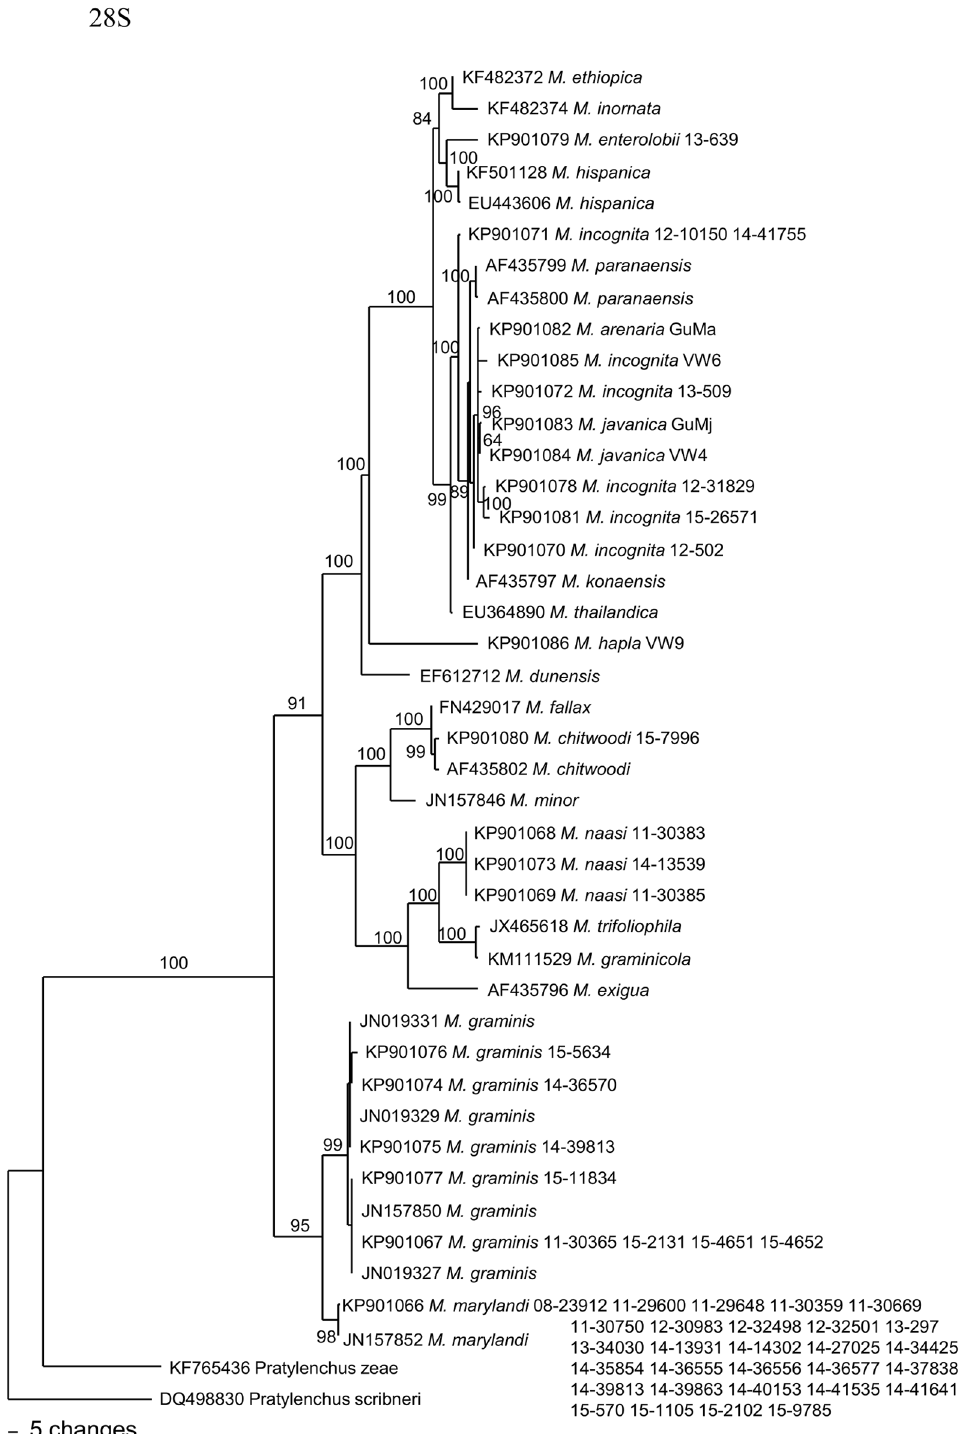
Fig 3. The 10001st Bayesian tree inferred from 28S D2/D3 under TVM+I+G model (-lnL = 4970.2949; AIC = 9958.5898; freqA = 0.2484; freqC = 0.1933; freqG = 0.2727; freqT = 0.2855; R(a) = 0.5776; R(b) = 2.9297; R(c) = 1.8072; R(d) = 0.228; R(e) = 2.9297; R(f) = 1; Pinvar = 0.2661; Shape = 0.6378) . Posterior probability values exceeding 50% are given on appropriate